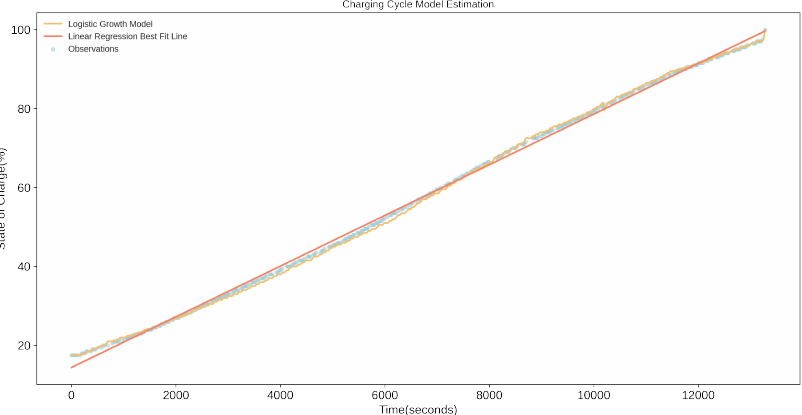
Figure 11. Real characteristic–charging curve of Hyundai Ioniq Battery Electric based on measured charging